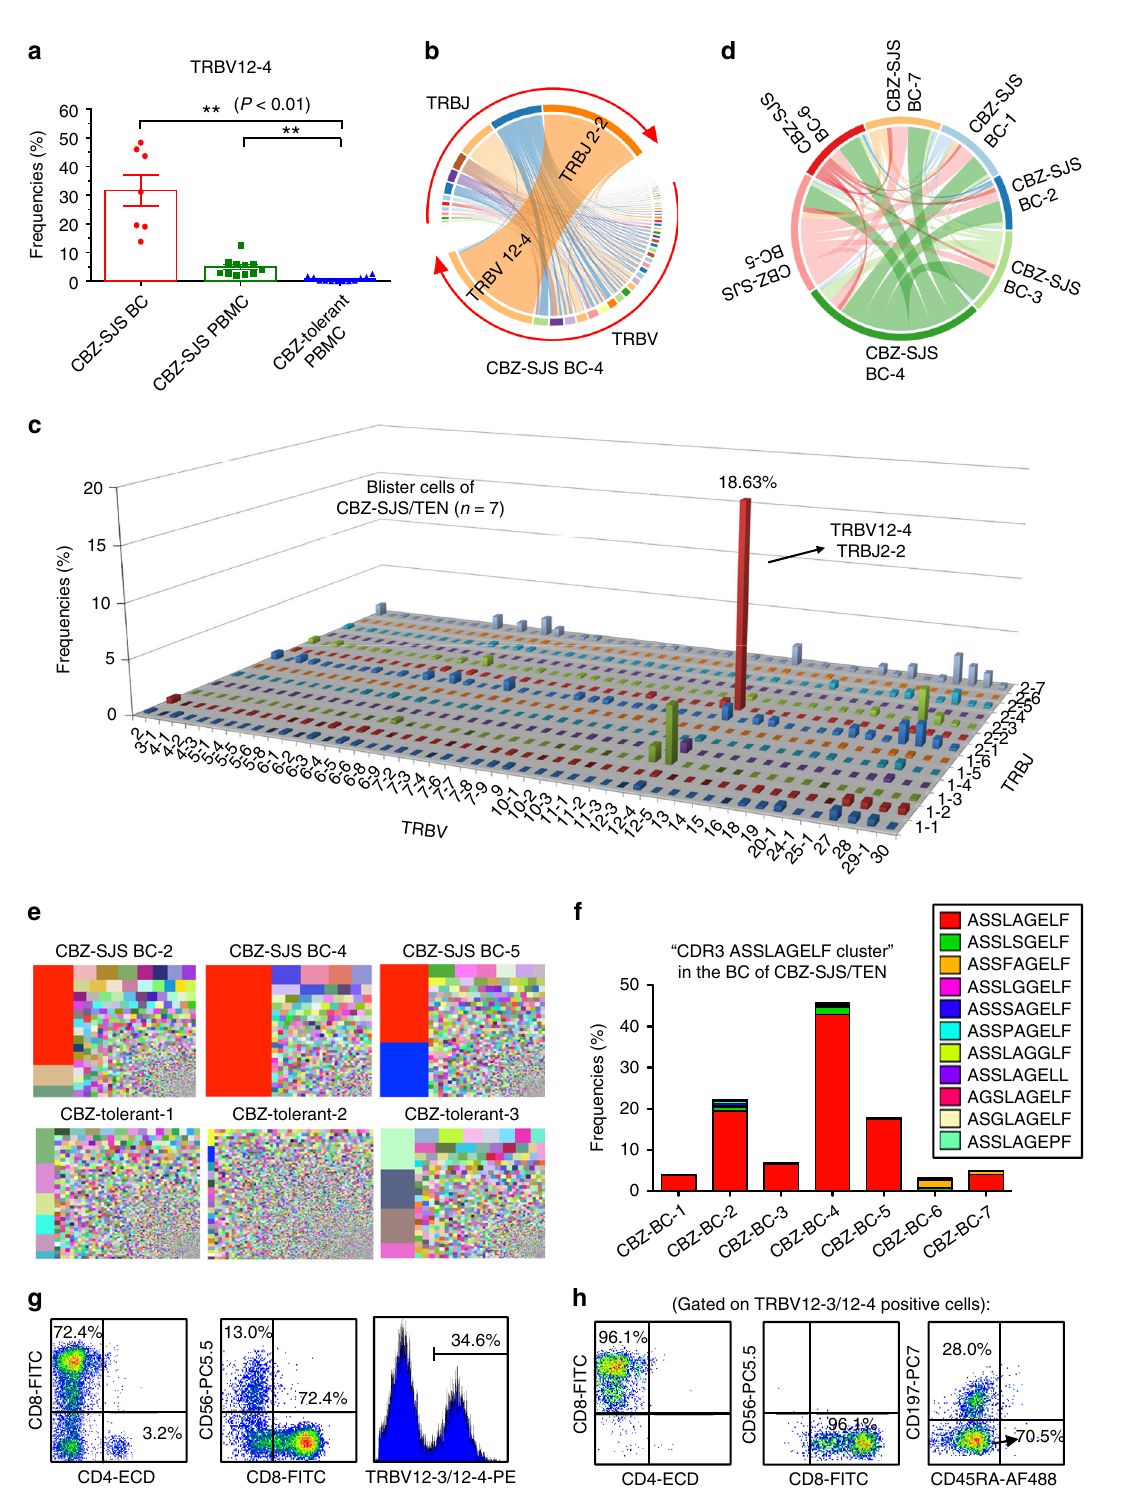
B*15:02 based on the crystal structure of HLA-B*15:01 (PDB 1XR8) and a peptide motif identi fi ed from CBZ-treated cells 23